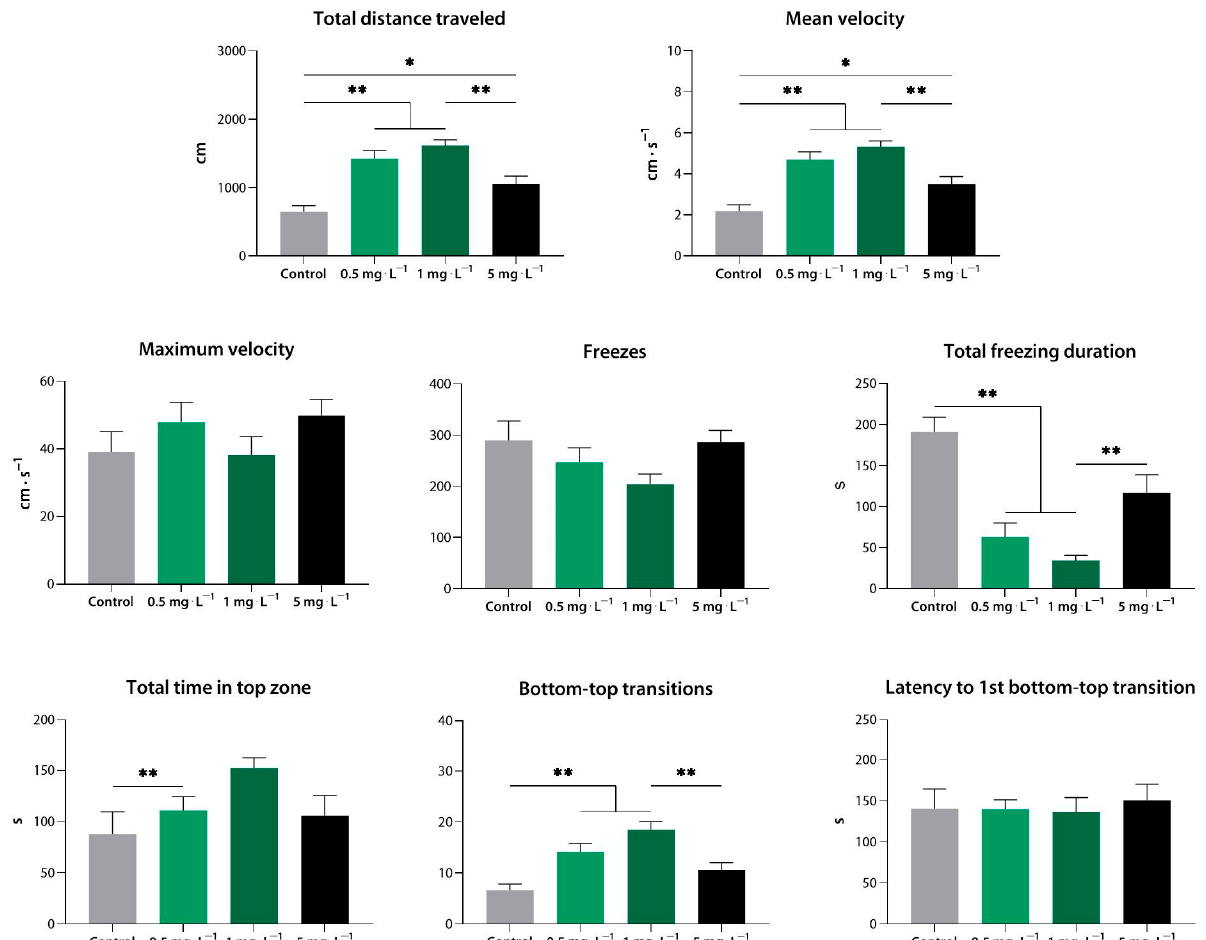
Figure 11. Compound 4 ( 33a ) at low concentrations induces an anxiolytic-like effect in zebrafish, as assessed using the novel tank test. *, p < 0.05; **, p < 0.01.